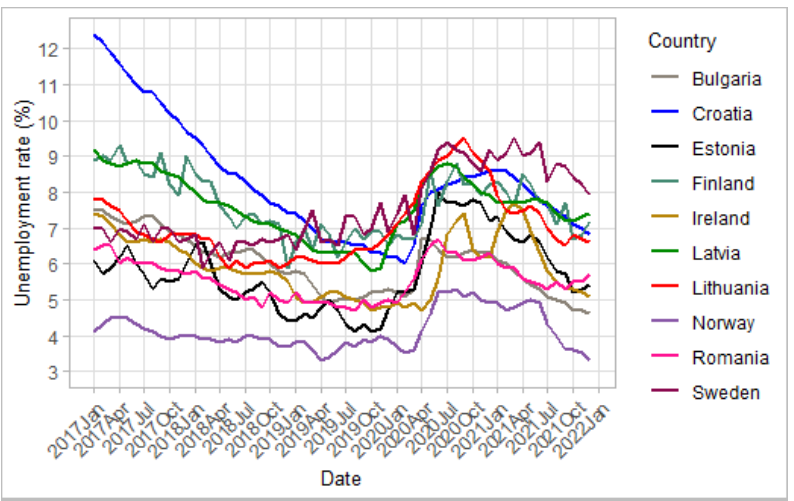
Figure 5. Trend of unemployment rate (seasonally adjusted data) before and during the COVID-19 pandemic.